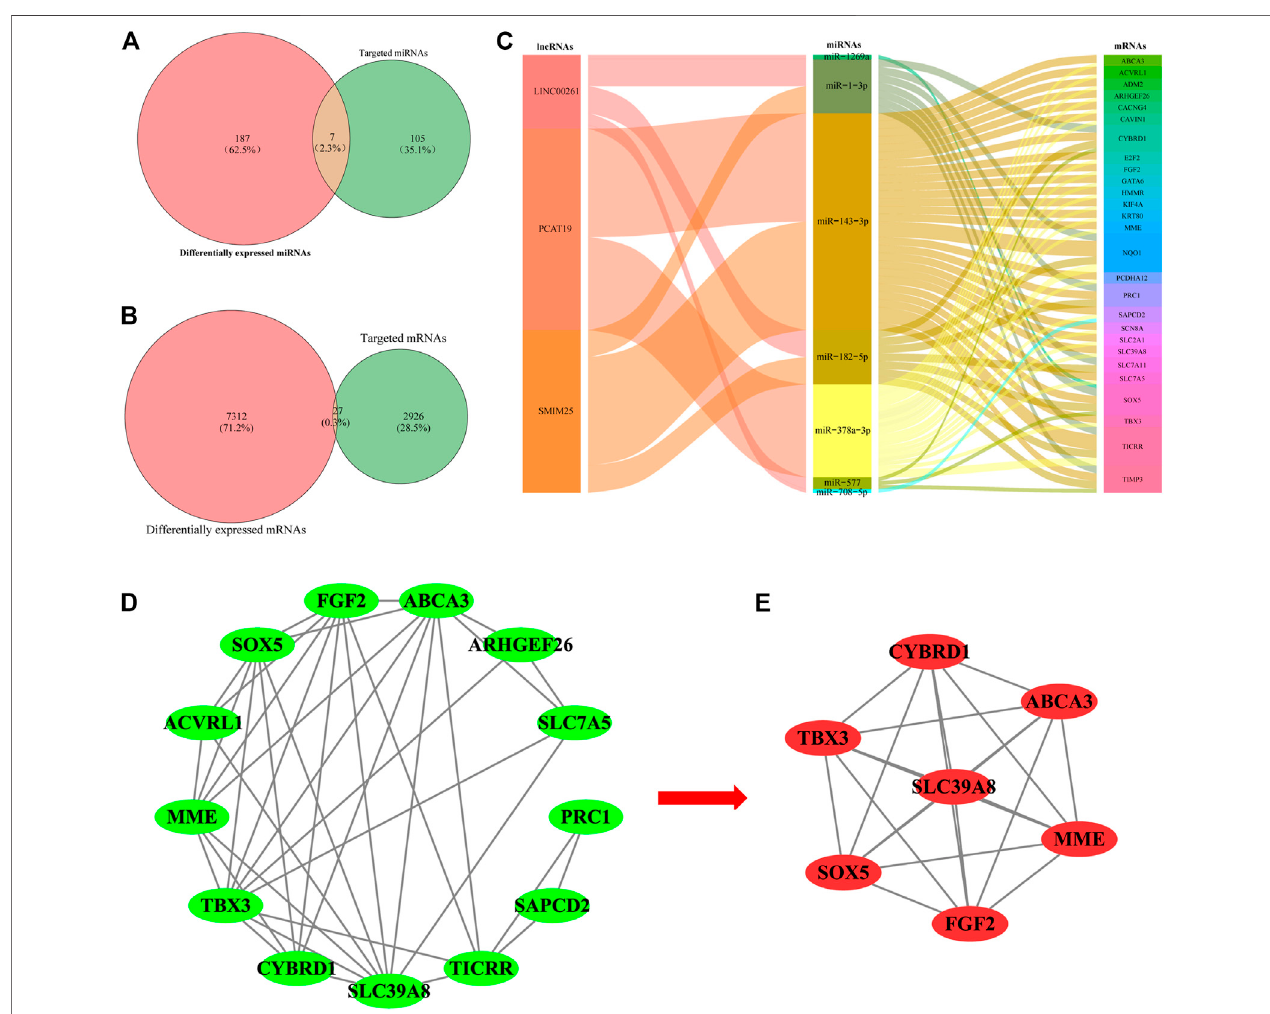
FIGURE2| Venn diagram ofthe common (A) miRNAsand (B) mRNAsbetweendifferentially expressed miRNAs/mRNAs and target miRNAs/mRNAs. (C) Sankey diagram of the ceRNA network in lung adenocarcinoma. Each rectangle represents a gene, and the degree of connectivity of each gene is indicated by the size of the rectangle. (D) PPI network ofthe lncRNA-correlated mRNAs in the ceRNA network. (E) Most signi fi cant module in the PPI network of the lncRNA-correlated mRNAs by the MCODE plug-in.